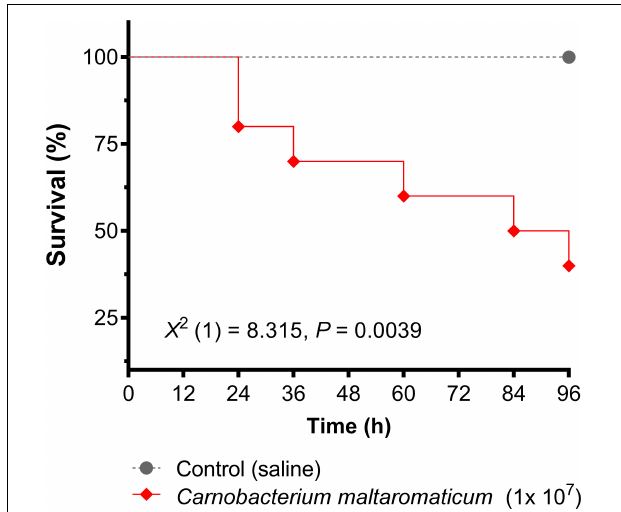
FIGURE 3 | Survival of whiteleg shrimp, Penaeus vannamei , over 96 h post inoculation with Carnobacterium maltaromaticum . Each shrimp was administered 1 × 10 7 bacteria via intramuscular injection ( n = 10 per group, 20 in total). Data were analyzed using the log-rank (Mantel–Cox) curve comparison